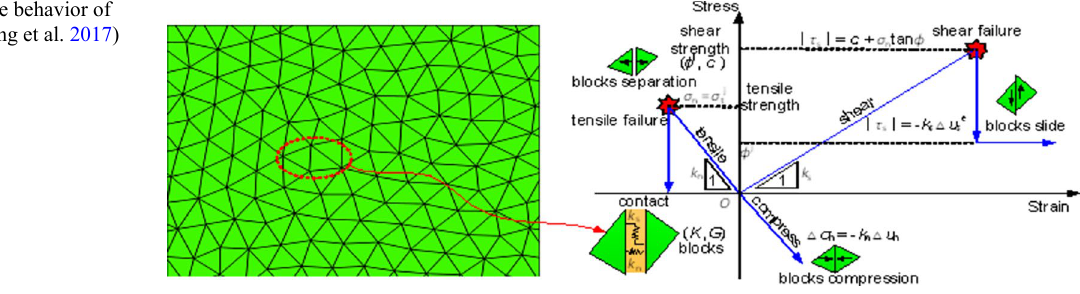
Fig. 4 Constitutive behavior of contacts (after Yang et al.